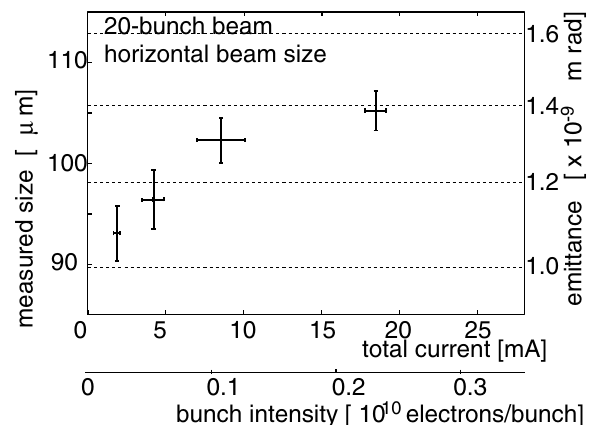
FIG. 11. Horizontal emittance of the 20-bunch beam vs the electron